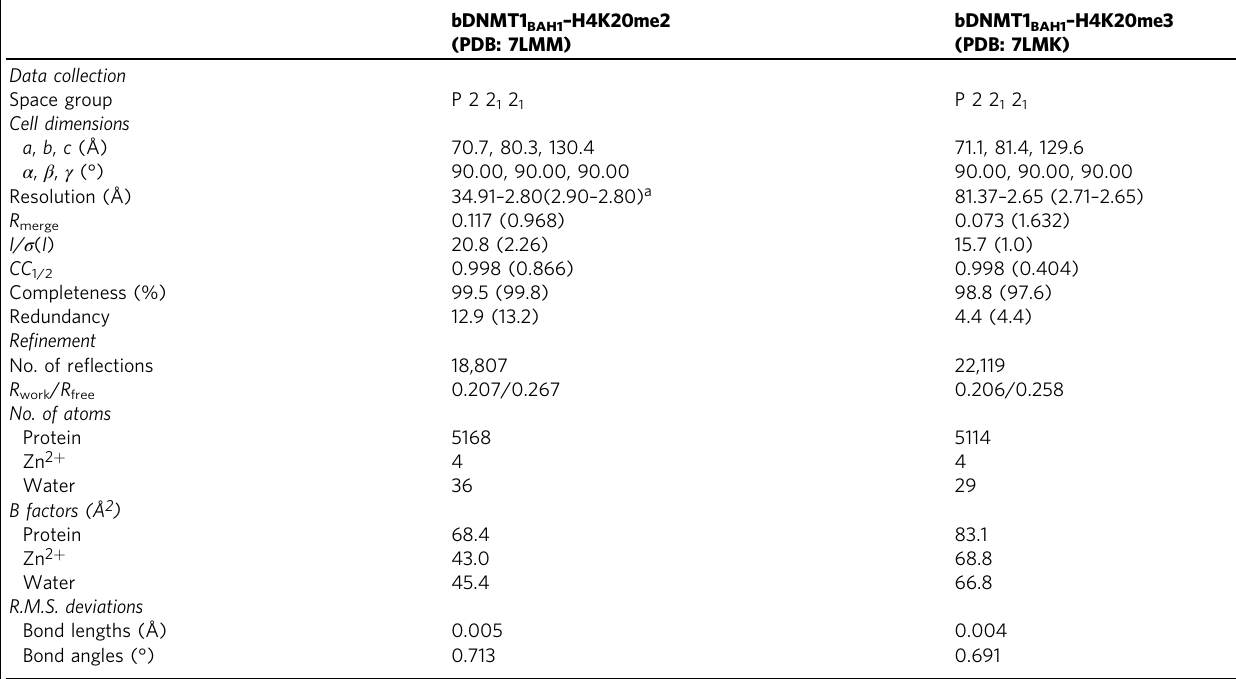
Table 1 Data collection and re fi nement